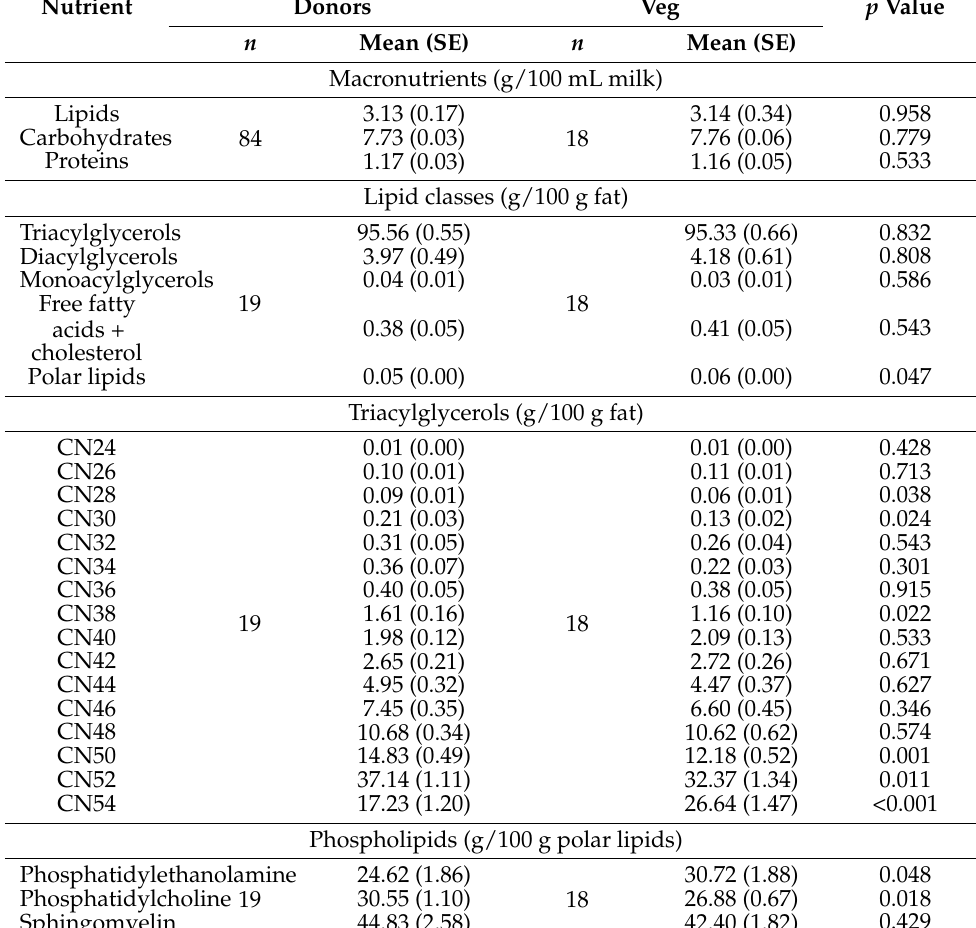
Table 11. Macronutrient composition (g/100 mL milk), lipid classes’ profile (g/100 g fat), relative composition of phospholipids (g/100 g polar lipids) and molecular species of triacylglycerols content (g/100 g fat) according to their carbon number (CN) in the human milk of the omnivore human milk donors with full-term infants (Donors) and in the vegetarian/vegan mothers